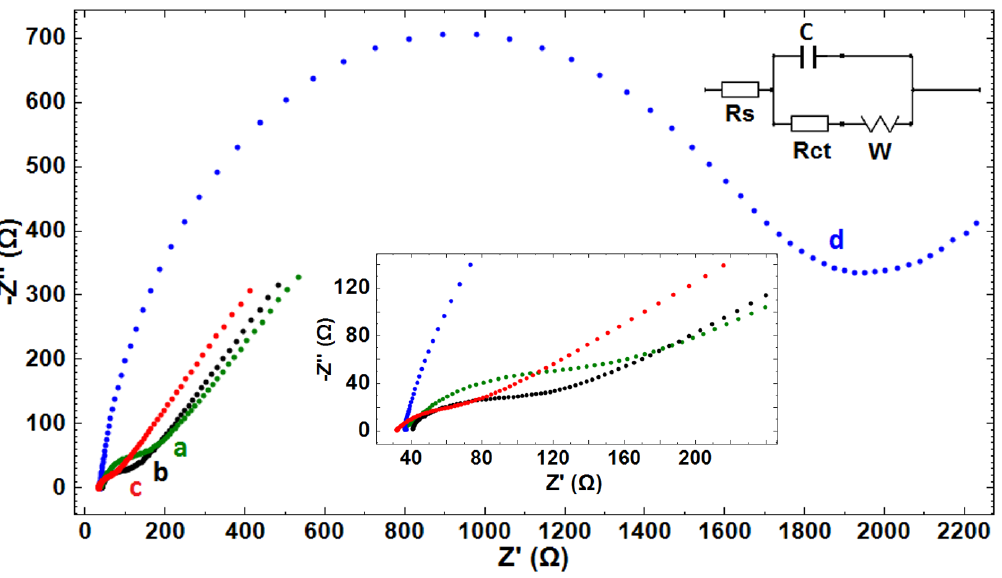
Table 3. EIS response parameters obtained after curve fit of the Nyquist diagrams presented in Fig- ure 4 using Randles circuit.